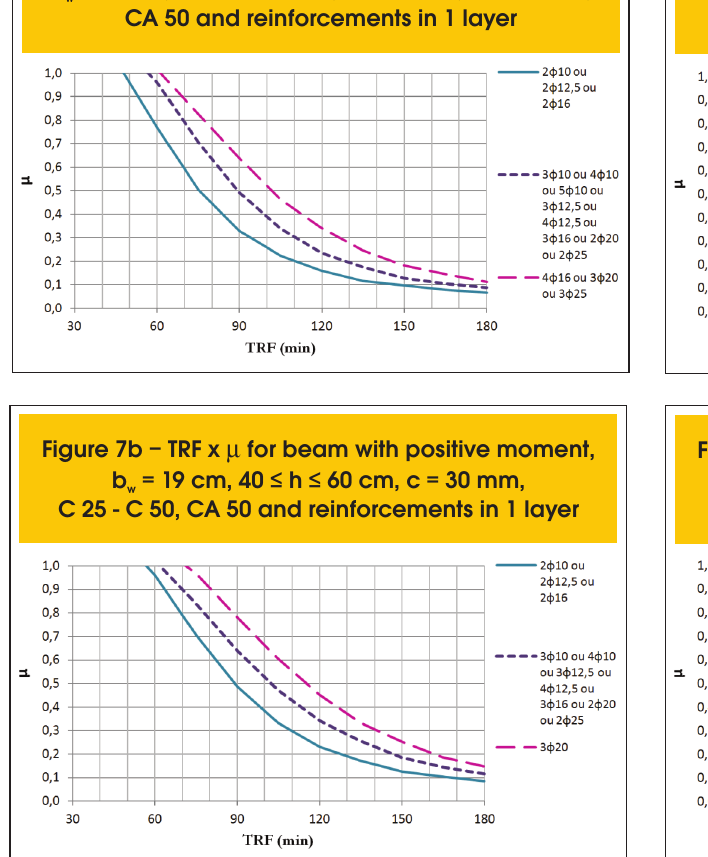
Figure 7a – TRF x m for beam with positive moment, b = 19 cm, 40 ≤ h ≤ 60 cm, c = 25 mm, C 25 - C 50, w